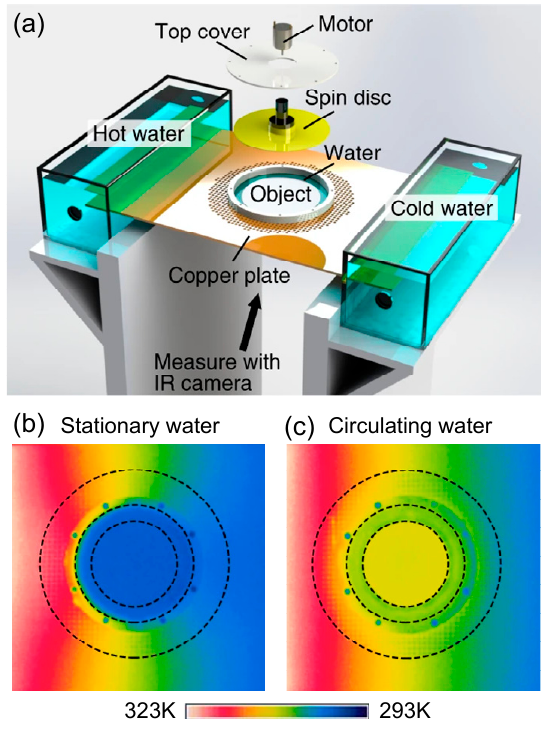
Figure 9. Experimental demonstration of a convective thermal zero-index cloak [73]. ( a ) Experimental setup; ( b ) measured temperature distribution when the water in the central channel is at rest; ( c ) measured temperature distribution when the water is circulating around the object.